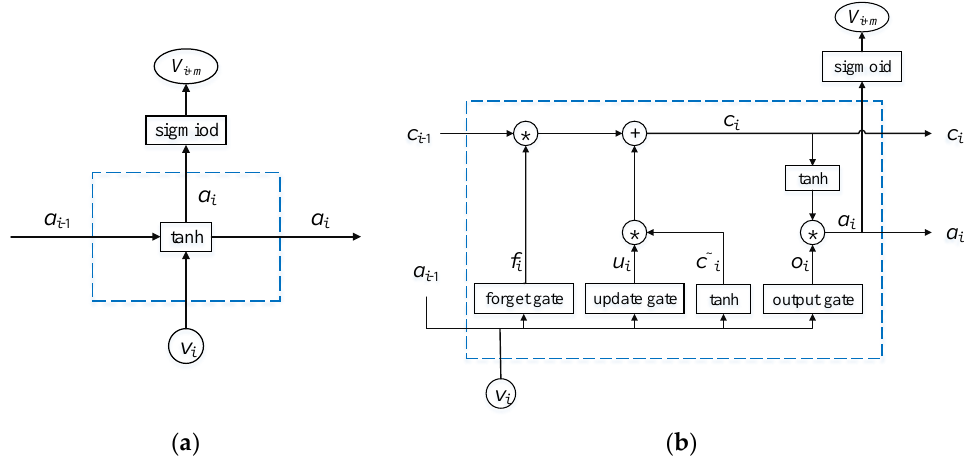
Figure 2. The structure of forecasting model for wind speed series at the time-step i : ( a ) the RNN forecasting model; ( b ) the LSTMNN forecasting model.